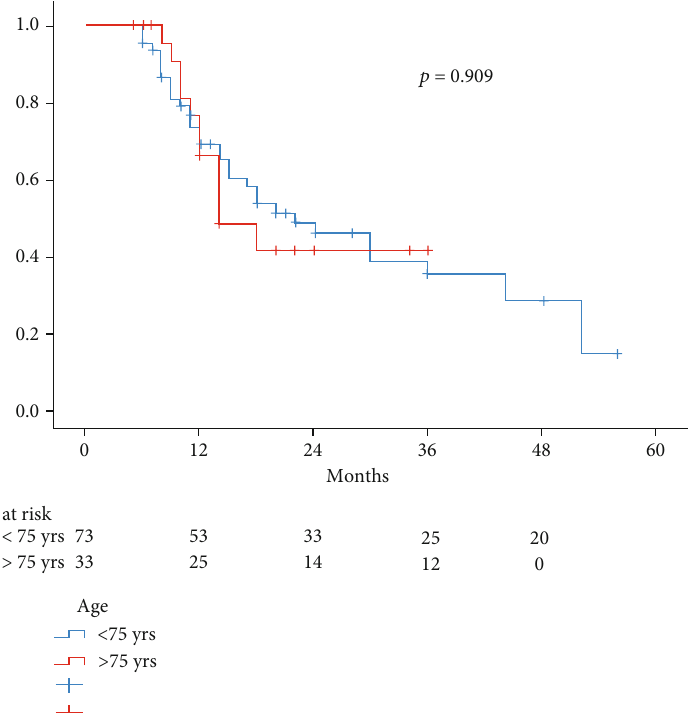
Figure 1: Overall survival of 106 patients who have undergone pancreatoduodenectomy for periampullary neoplasms, according to age strati fi